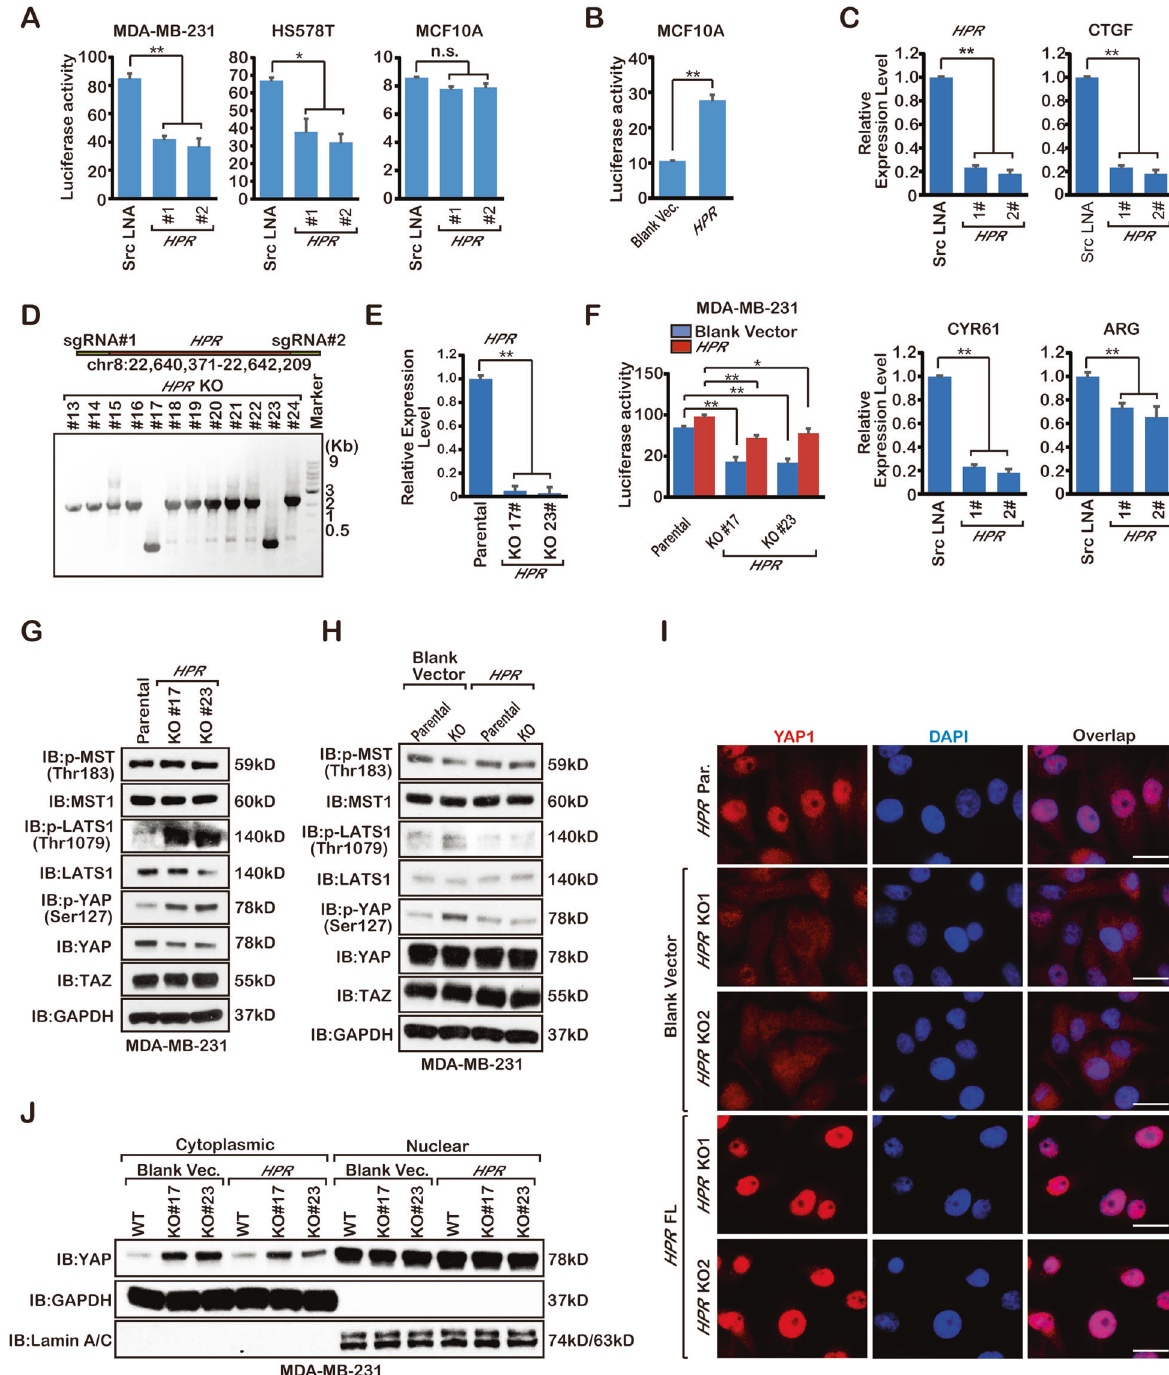
Fig. 3 HPR regulates Hippo pathway activation. a Reporter assay detection of the activation of YAP1 in MDA-MB-231, HS578T and MCF10A cells transfected with the LNA of HPR (* P < 0.05, ** P < 0.01). The results are the mean ± s.e.m. of n = 3 independent experiments. P values were determined by one-way ANOVA. b Reporter assay detection of the activation of YAP1 in MCF10A cells transfected with HPR cDNA (* P < 0.05, ** P < 0.01). The results are the mean ± s.e.m. of n = 3 independent experiments. P values were determined by one-way ANOVA. c qPCR detection of HPR and substrates of YAP1 expression (** P < 0.01). The results are the mean ± s.e.m. of n = 3 independent experiments. P values were determined by one-way ANOVA. d CRISPR-Cas9 knockout of HPR in MDA-MB-231 cells. e qPCR detection of HPR expression in the MDA- MB-231 cells (** P < 0.01). The results are the mean ± s.e.m. of n = 3 independent experiments. P values were determined by one-way ANOVA. f Reporter assay detection of the activation of YAP1(* P < 0.05, ** P < 0.01). The results are the mean ± s.e.m. of n = 3 independent experiments. P values were determined by one-way ANOVA. g , h Immunoblotting detection using the indicated antibodies in HPR -knockout MDA-MB-231 cells. Three independent experiments were performed and yielded similar results. i Immuno fl uorescence detection using indicated antibodies in the HPR- knockout MDA-MB-231 cells. j Immunoblotting detection using the indicated antibodies in HPR- knockout MDA-MB-231 cells. Three independent experiments were performed and yielded similar